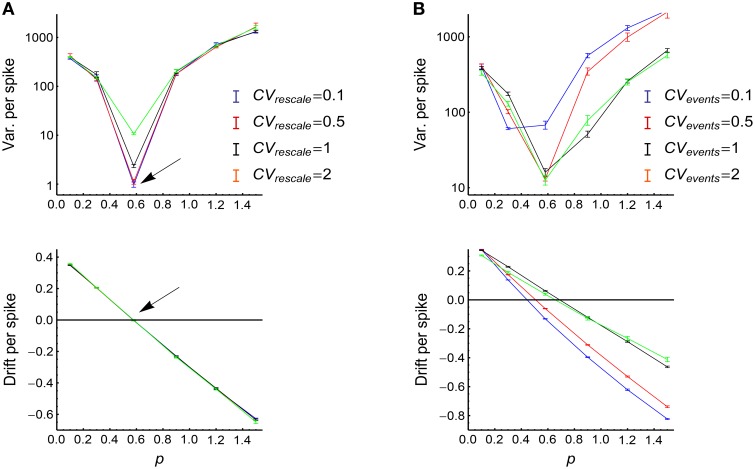
The influence of auto-correlation structure onto the efficacy variability under synchronous firing and heterogeneity of rates. (A) Upper: Variance per spike as a function of p at different CVrescale, keeping CVevents = 0.71 and s = 1 (see Model Sync-Auto-LongTail in Section 2). Lower: the corresponding mean efficacy changes per spike, which represent P-D imbalance. The arrows indicate the p value at which the mean efficacy change is almost zero (indicated by the horizontal black line), so DriftV ≈ 0 at this point due to P-D balance. Error bars represent s.e.m. in normal scale and relative errors corresponding to s.e.m. in log scale. (B) The same as (A) except that different lines represent different CVevents values, keeping CVrescale = 0.71. In (A,B), τcross = 2ms, Ap = 2, Ad = 1, τdelay = 1 ms. The size of the converging motif, as well as the simulation time and trials are the same as in Figure 4.